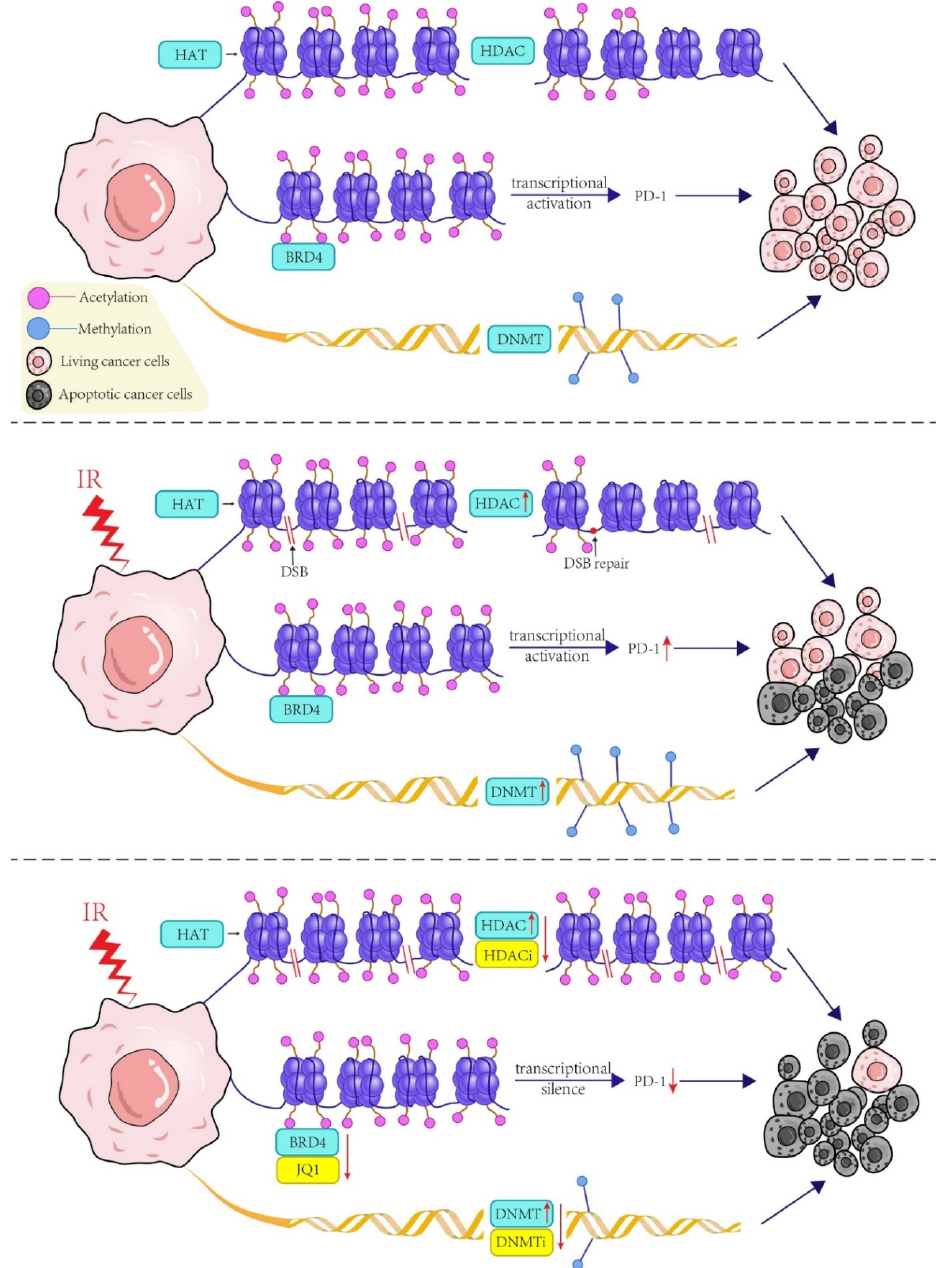
Figure 3. In normal growth and proliferation of tumor cells, histone is regulated by HAT and HDAC acetylation and deacetylation; DNA methylation is regulated by DNMT; BRD4 and CD274 acetylation histone binding to regulate PD-L1 expression, indirectly playing a role in regulating tumor growth. Radiotherapy is an important treatment for tumor, which can promote tumor cell apoptosis by affecting the activities of HDAC, DNMT and PD-L1 to a certain extent. Enhanced activity of HDAC and DNMT promotes histone deacetylation and DNA methylation, leading to accelerated DSB repair. At the same time, radiotherapy can induce the up-regulation of PD-L1 and lead to the escape of tumor cells. In combination with radiotherapy and epigenetic modifiers, HDACi combined with HDAC decreased the activity of HDAC and inhibited DSB repair. DNMT inhibitors promote cell damage by binding DNMT; as a BRD4 inhibitor, JQ1 plays a role in reducing the expression of PDL1 induced by radiotherapy. All of them can enhance the apoptosis effect and play the role of radiotherapy sensitization. DNMTi: DNMT